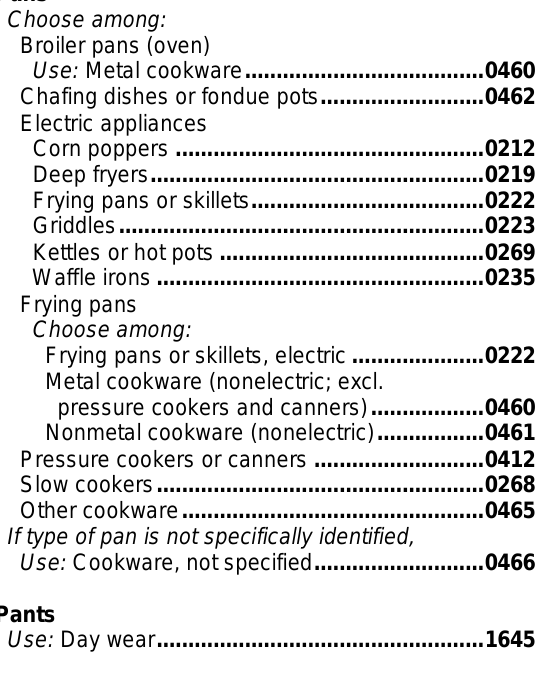
Paper towel holder Use: Kitchen gadgets, not elsewhere Paraffin Use: Candles, candlesticks and Parallel bars Use: Gymnastics (activity/apparel/equipment) ...